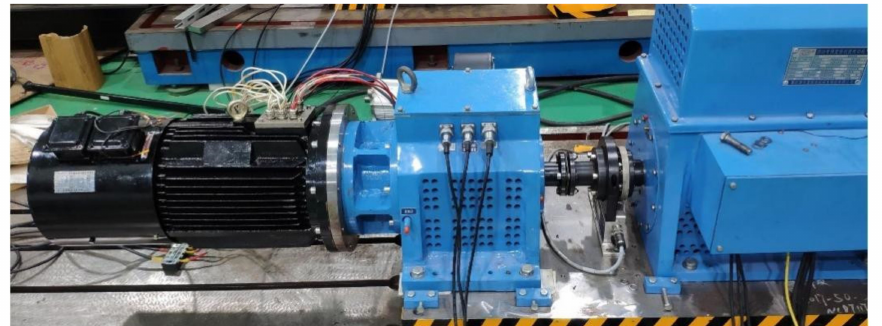
Figure 11. Zoom of the seven-phase IM and load machine.